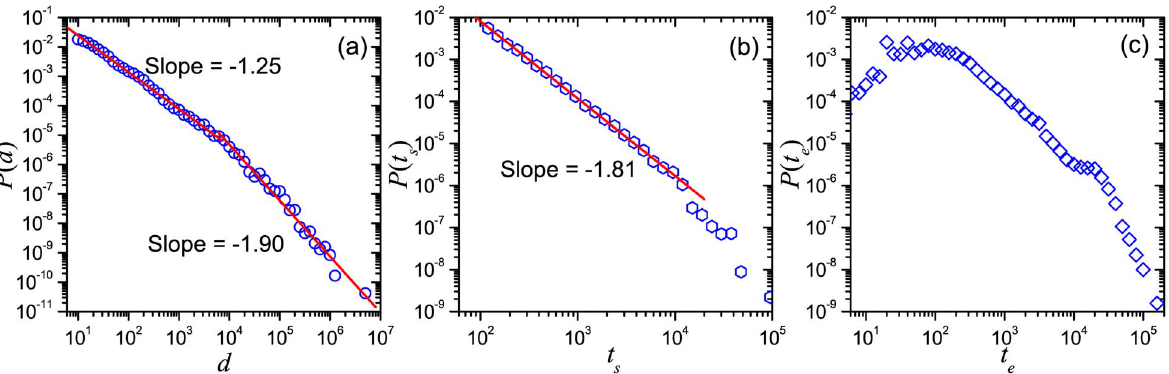
Figure 2. Aggregated mobility patterns. (a) The aggregated displacement distribution P ( d ) , (b) the staying time distribution P ( t s ) , (c) and the elapsed time distribution P ( t e ) in log-log plots.